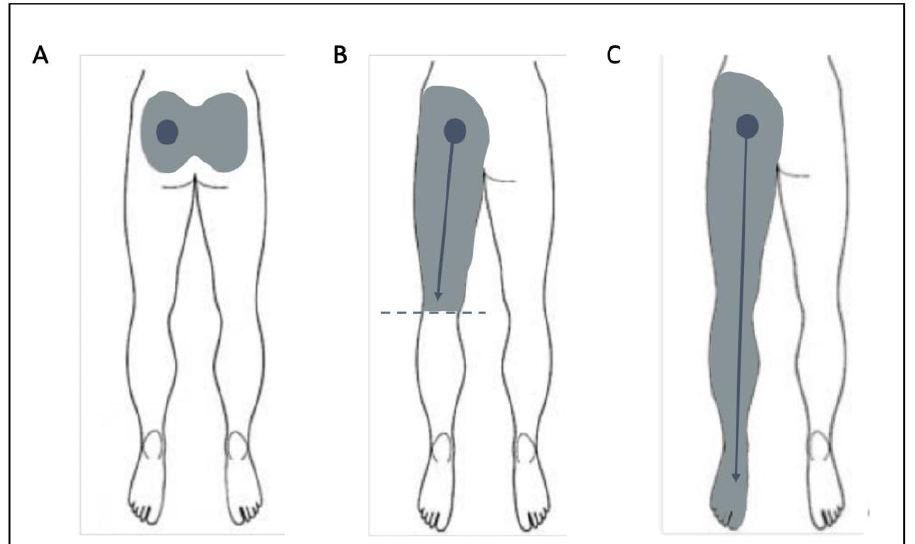
Figure 1. Pain Location Patterns. ( A ): lower back/buttocks only, ( B ): lower back/buttocks with pain radiating down to knees only, ( C ): lower back/buttocks with pain radiating past knees. Pain Location pattern D (not pictured) is lower back/buttocks with upper body pain. Diagrams adapted from Jung et al. [7] with permission.